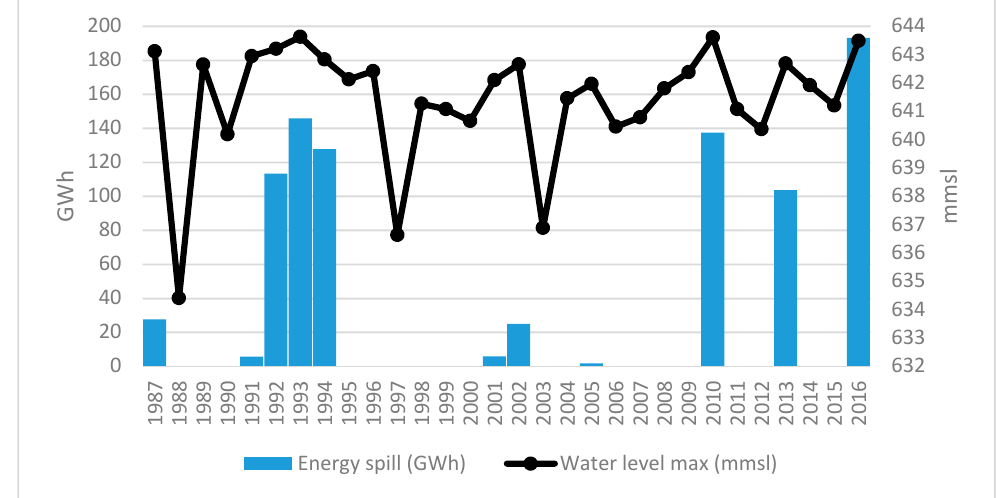
Figure 2. Annual maximum water levels and energy spills: Saguling HEPP from 1987 through to 2016. Source: own fieldwork.